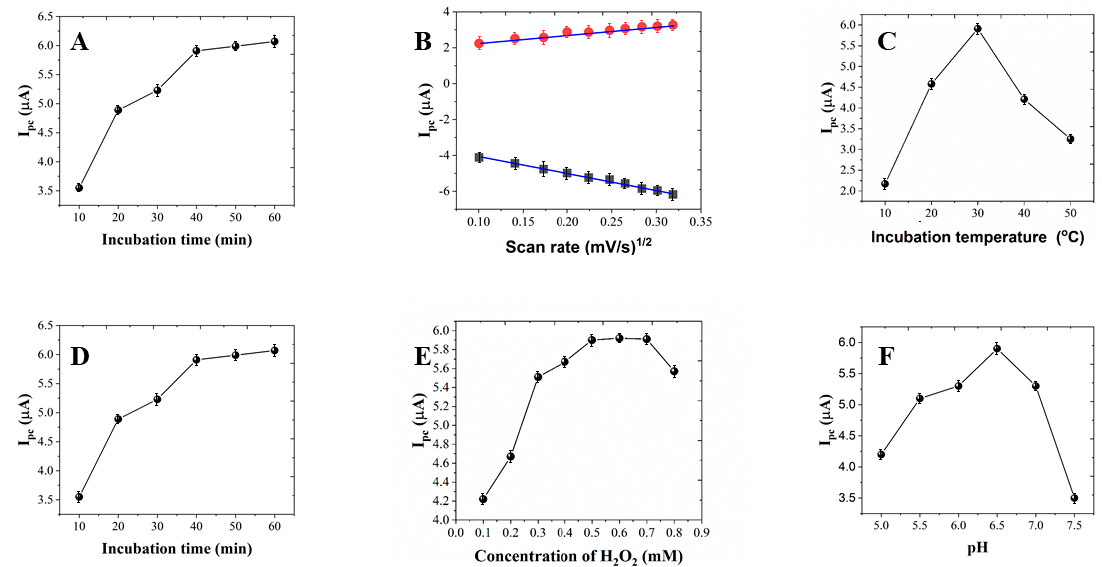
Figure 5. ( A ) Effect of incubation time between L. brevis and HRP-anti- L. brevis on the immunosensor. ( B ) Current response vs. square root of scan rate (red points and blue points for oxidation and reduction, respectively). ( C ) Effect of incubation temperature on the immunosensor. ( D ) Effect of incubation time between anti- L. brevis and L. brevis on the immunosensor. ( E ) Effect of concentration of H 2 O 2 on the immunosensor. ( F ) Effect of pH condition on the immunosensor.